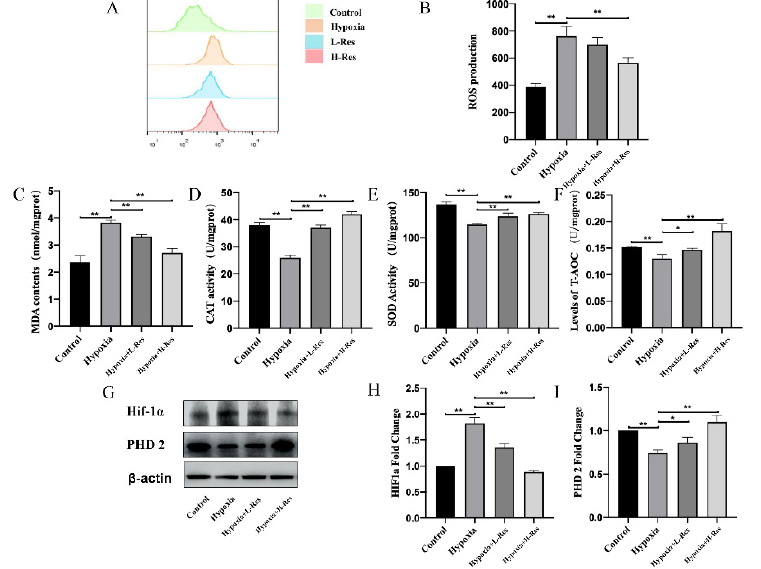
Figure 3. RES decreased accumulation of ROS and HIF-1 α in BMSCs under hypoxia. ( A , B ) The level of ROS in BMSCs from control group, hypoxia group, L-RES group and H-RES group was detected and quantified. The content of ( C ) MDA and the activity of ( D ) CAT, ( E ) SOD, ( F ) T-AOC in BMSCs from control group, hypoxia group, L-RES group and H-RES group were determined. ( G ) The protein expression level of HIF-1 α and PHD2 in BMSCs from control group, hypoxia group, L-RES group and H-RES group was determined and ( H , I ) quantified. Values were expressed as mean ± SD. * p < 0.05, ** p < 0.01; all the assays were repeated more than three times.